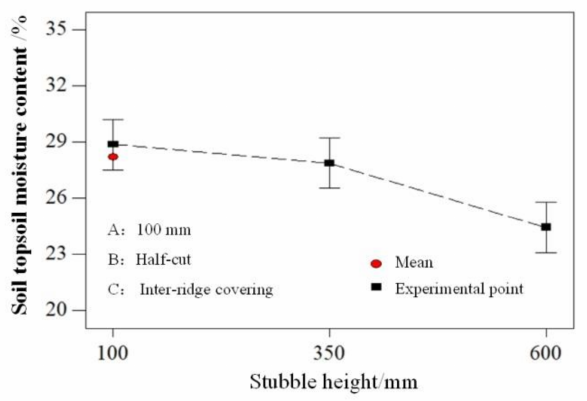
Figure 5. Effect of stubble height on soil topsoil moisture